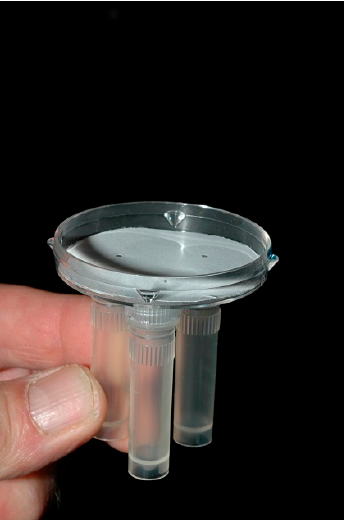
Figure 3. Olfactometer used to assess the response of neonates to cactus volatiles. See also Video S3.